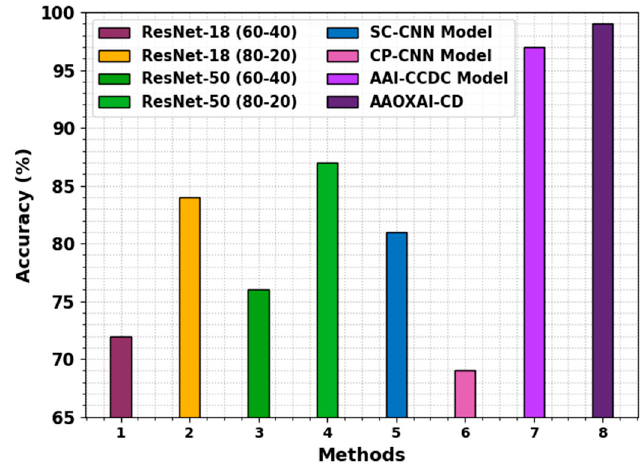
Figure 9. Comparative analysis of the AAOXAI-CD approach on dataset-1.